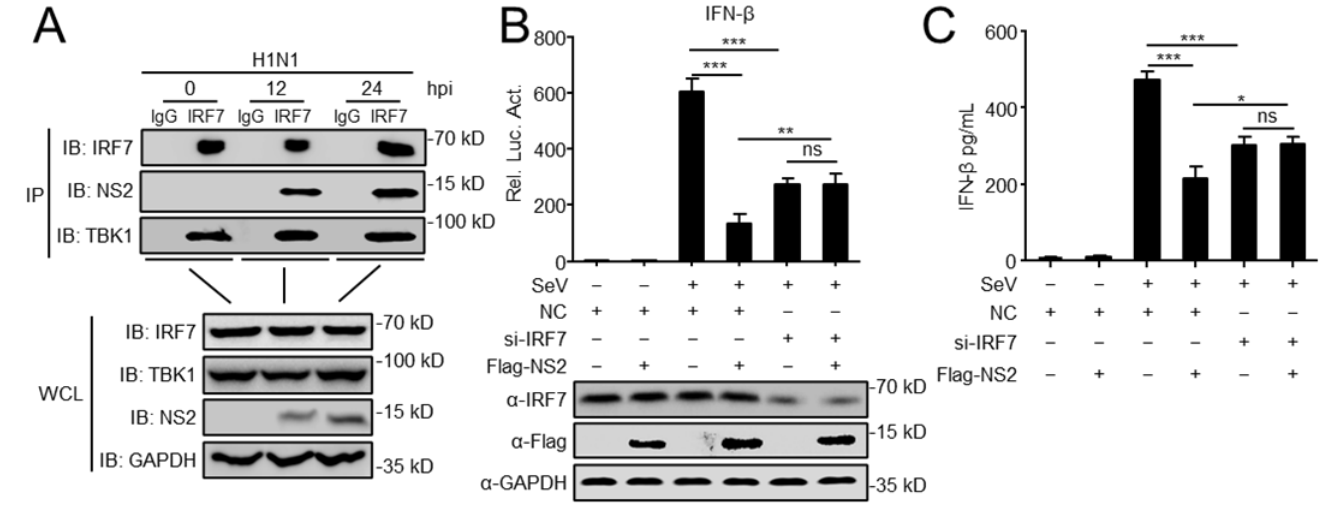
Figure 3. NS2 targets IRF7 and inhibits IFN-I production. ( A ) Endogenous NS2 is associated with IRF7. A549 cells were infected with H1N1 virus (MOI = 0.1) for the indicated times before co- immunoprecipitation and immunoblot analysis. ( B ) Luciferase reporter plasmids (IFN β -Luc) and the pRL-TK plasmid were co-transfected into HEK293 cells, along with Flag-NS2 and IRF7 siRNA or scrambled siRNA (NC). At twenty hours after transfection, cells were left untreated or treated with SeV for 12 h before reporter assays. ( C ) HEK293 cells were transfected with H1N1-NS2 or Vec, along with Flag-NS2 and IRF7 siRNA or NC for 24 h. Then cells were infected with SeV for 12 h. The concentrations of IFN- β in the supernatants were then detected by using human IFN- β DuoSet ELISA kit. The data shown represent three independent experiments ( p < 0.05 (*), p < 0.01 (**), p < 0.001 (***), ‘ns’ indicates no significant difference ).